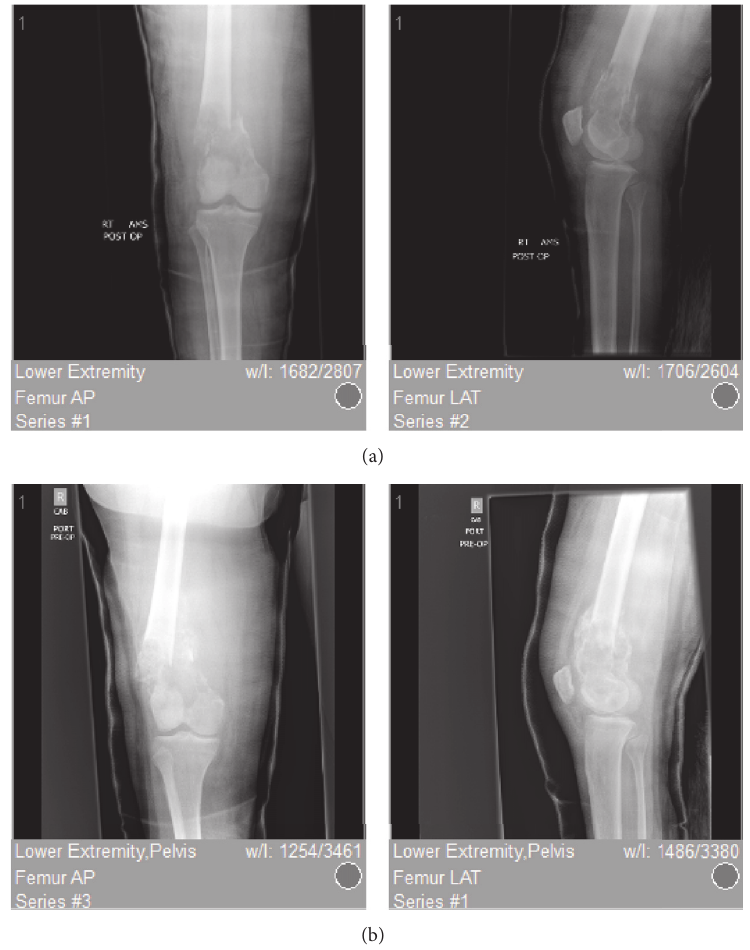
Figure 1: Preoperative AP/lateral radiographs showing an expansile, aggressive-appearing, lytic lesion of the distal femur with associated extra-articular pathologic fracture. (a) shows prereduction AP and lateral radiographs of a left distal femur pathologic fracture; (b) shows AP and lateral radiographs status, after reduction and